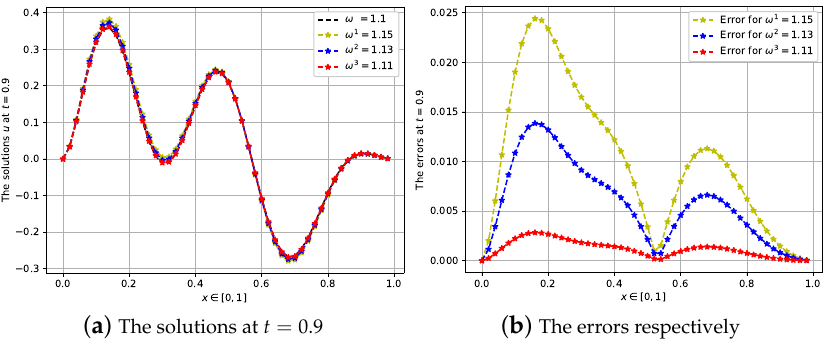
Figure 4. The solution u for ω = 1.1, ω i ∈ { 1.15,1.13,1.11 } at t = 0.9 and the respective